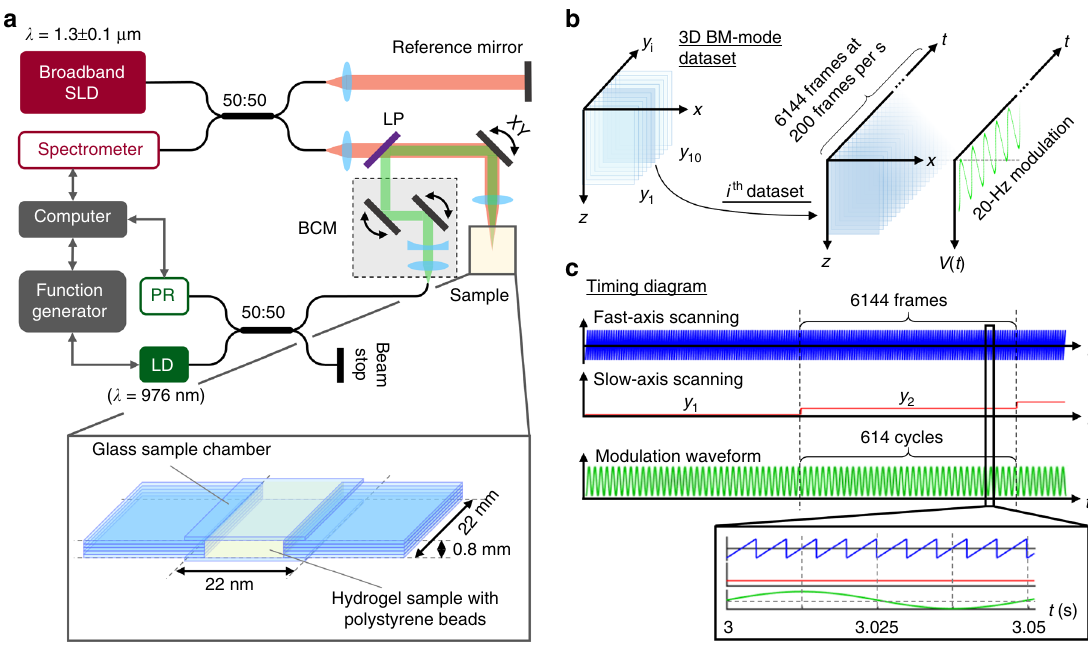
Fig. 2 Optical setup and data acquisition scheme for volumetric mechanical microscopy with PF-OCE. a The optical setup consisted of an SD-OCT system and a PF forcing beam combined in free space with the OCT sample arm beam. A function generator provided external modulation of the power of the PF forcing beam. b Illustrations of 3D BM-mode dataset for the beam-scanning (200-Hz frame rate) and modulation waveform (20-Hz modulation frequency) from the function generator for a 3D BM-mode acquisition. c Associated timing diagram for the acquisition scheme. SLD: superluminescent diode, LD: laser diode, PR: photoreceiver, LP: long-pass dichroic fi lter, BCM beam control module, XY two-axis